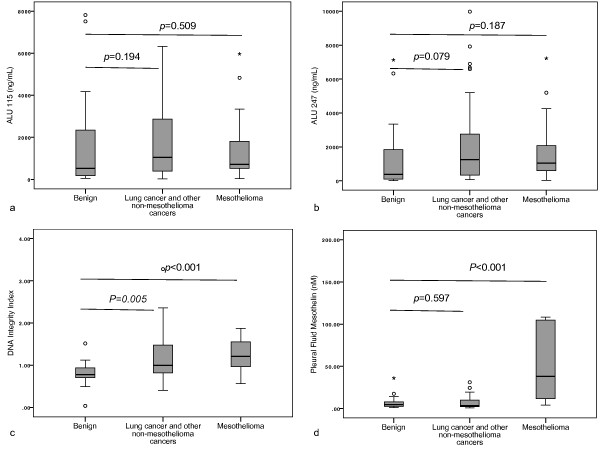
Box plots of pleural effusion DNA fragments, integrity index and mesothelin concentrations in subjects with effusions due to benign aetiology, other cancers and mesothelioma. DNA fragment values were determined by quantitative PCR for ALU (a) 115bp fragment and (b) a 247bp fragment. The DNA integrity index (c) was defined as the ratio of ALU 247/ALU 115 fragment levels. Mesothelin values (d) were determined by ELISA. Mann-Whitney U test to was used to assess for any differences in comparison to benign effusions and p values <0.05 were deemed significant.